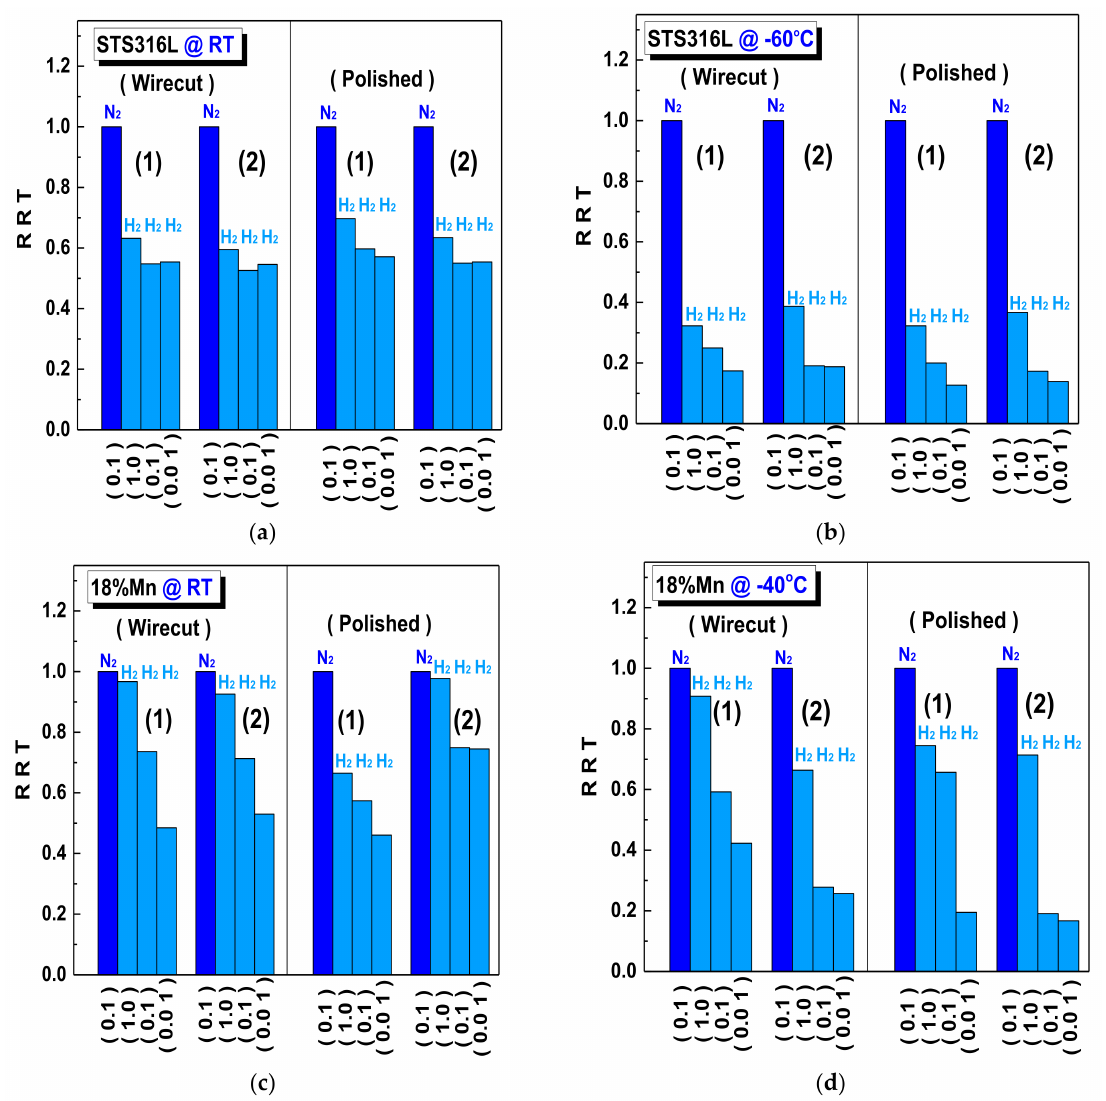
Figure 6. Comparisons of RRTs obtained at RT and lower test temperatures at each punch velocity, separated by surface finish for ( a , b ) STS316L steel and ( c , d ) 18 wt% Mn